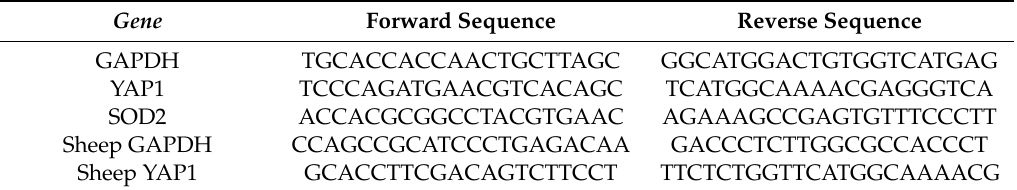
Table 3. Primer Pairs Used for RT-PCR (5 (cid:48) to 3 (cid:48)